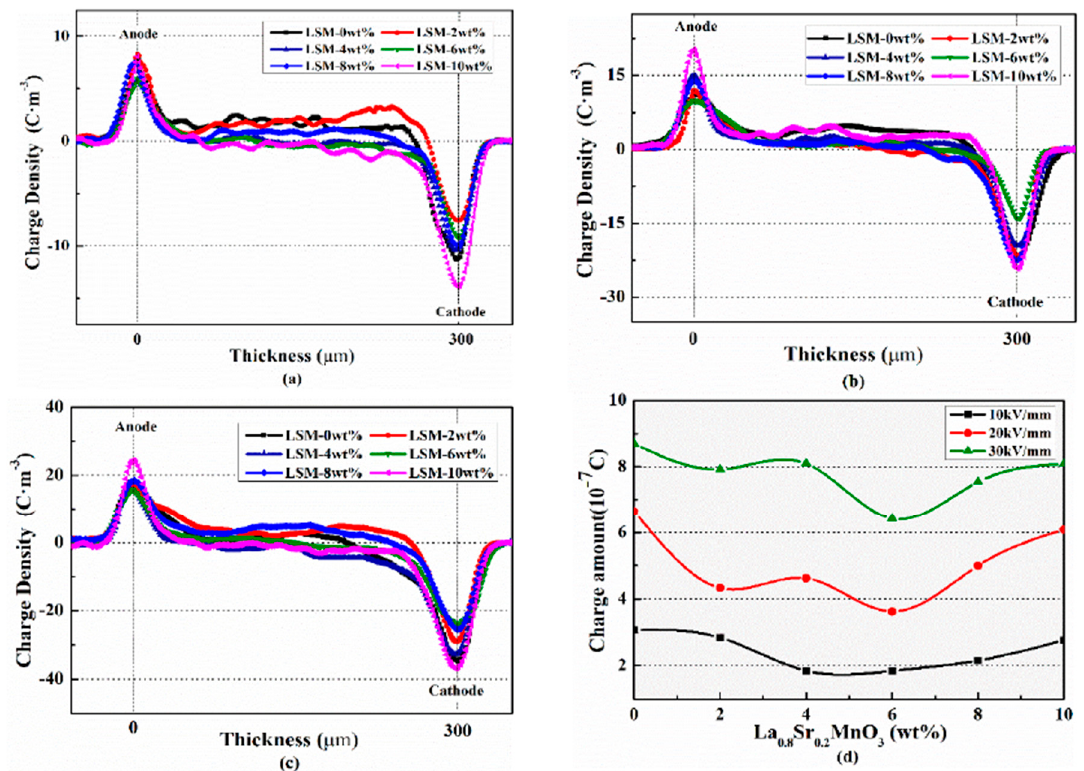
Figure 9. Comparison of space charge distributions at 1800 s in the insulation samples under semi-conductive composites with di ff erent La 0.8 S r0.2 MnO 3 contents. ( a ) 10 kV / mm; ( b ) 20 kV / mm; ( c ) 30 kV / mm; ( d ) space charge amount.